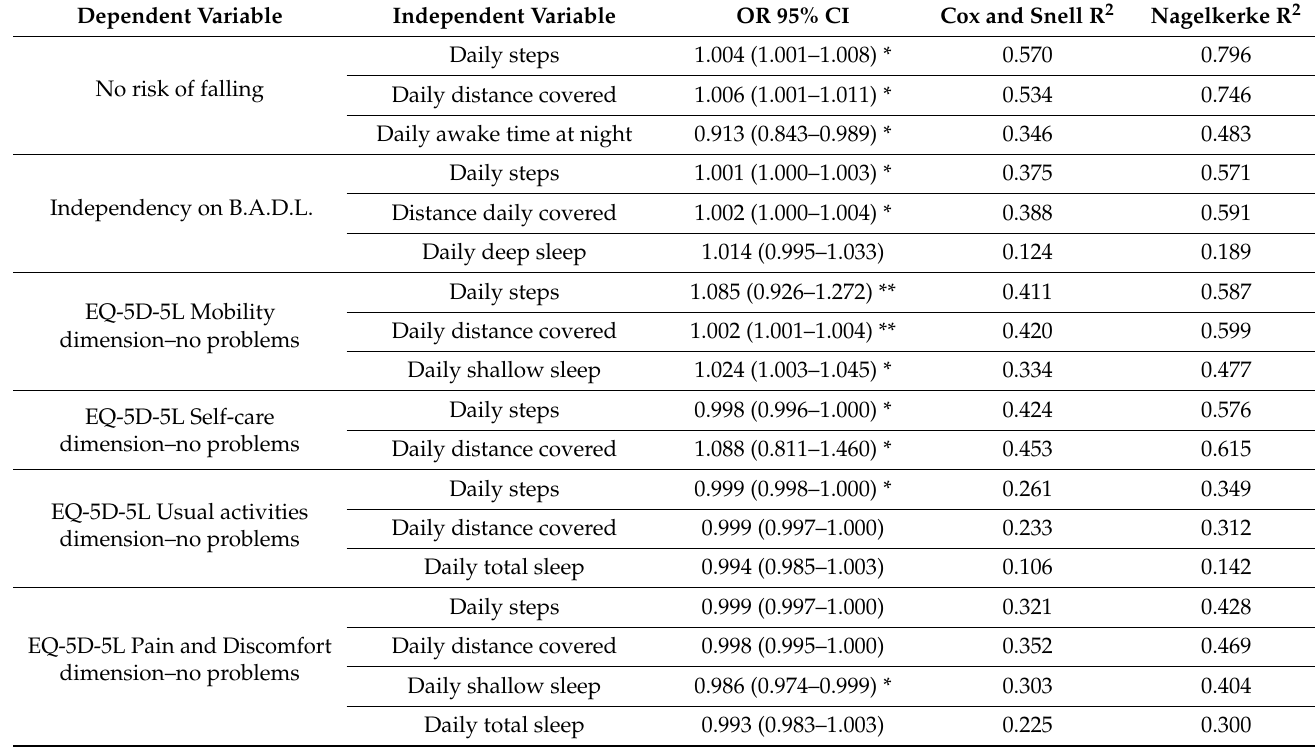
Table 5. Binary regression of Xiaomi Mi Band